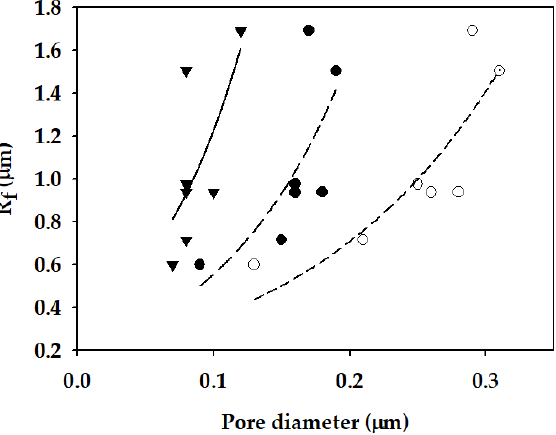
Figure 11. Dependence of R f on pore sizes of fabricated membranes ( ▼ : minimum pore diameter; ●: mean pore diameter; ○ : maximum pore diameter).